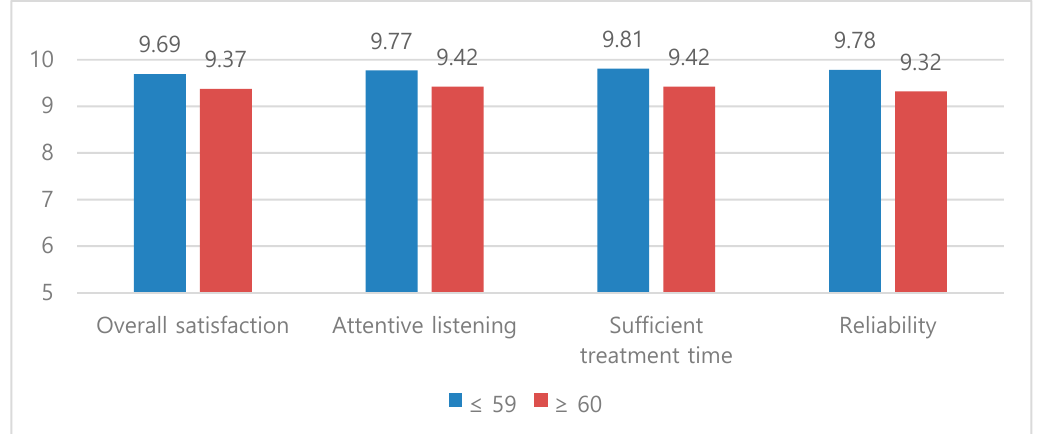
Figure 1. Patient satisfaction and reliability by age in the MDT-WfO group.